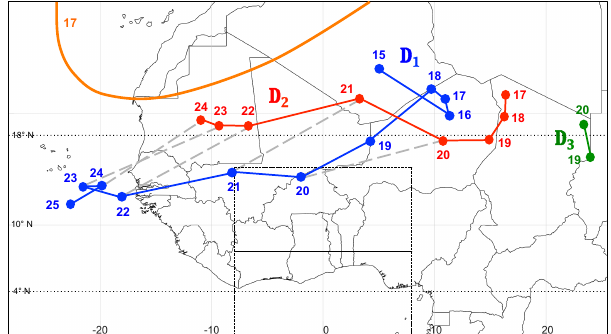
Figure 13. Significant synoptic-scale features during 15–25 July 2016 (transition from Phase 1 to Phase 2). To create this graph, vortices were subjectively identified in 850hPa streamlines based on operational ECMWF analyses. All vortex positions refer to 00:00UTC with the dates given as numbers. Round symbols mark cyclonic vortices (labelled D 1 , D 2 and D 3 ) and the thick orange line shows the southernmost extension of a significant trough at 600hPa (see Fig. 12). Vortices with a joint propagation are linked with dashed grey lines. The boxes mark the areas used to compute the NSPD shown in Fig. 5a. The stippled lines show the latitude range used to produce Fig.